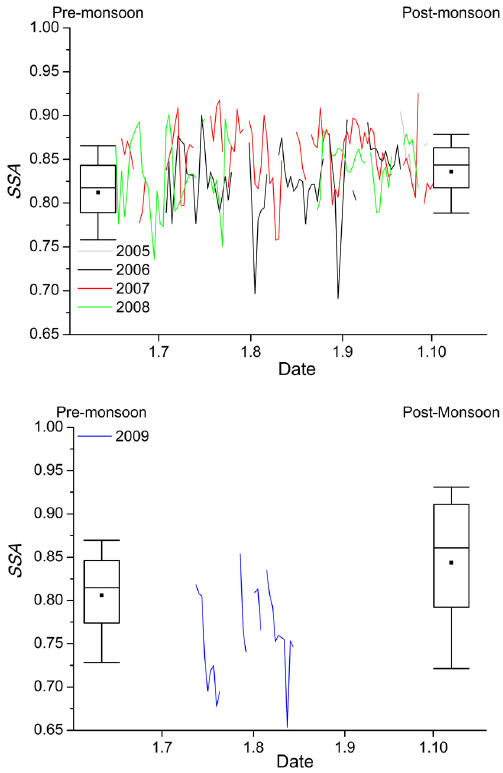
Fig. 8. Single scattering albedo, SSA at 525nm. (a) Mukteshwar (b) Gual Pahari. Lines are 24h running averages from the mon- soon season, box plots denote to pre- and post-monsoon seasonal values of 10%-ile, 25%-ile, median (line), average (dot), 75%-ile and 90%-ile.